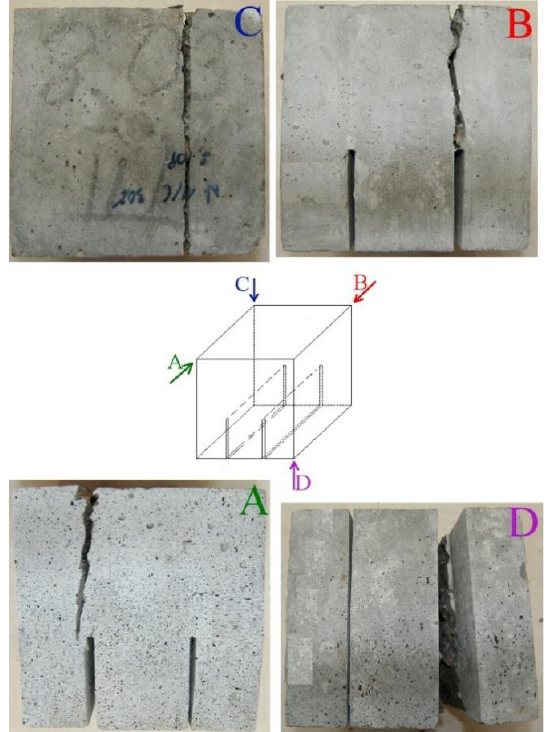
Figure 13. View of cracks occurring on the characteristic planes of the specimen: A–D—description in the text.